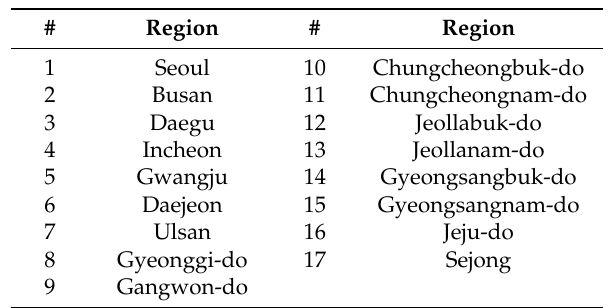
Table 2. A list of regions.